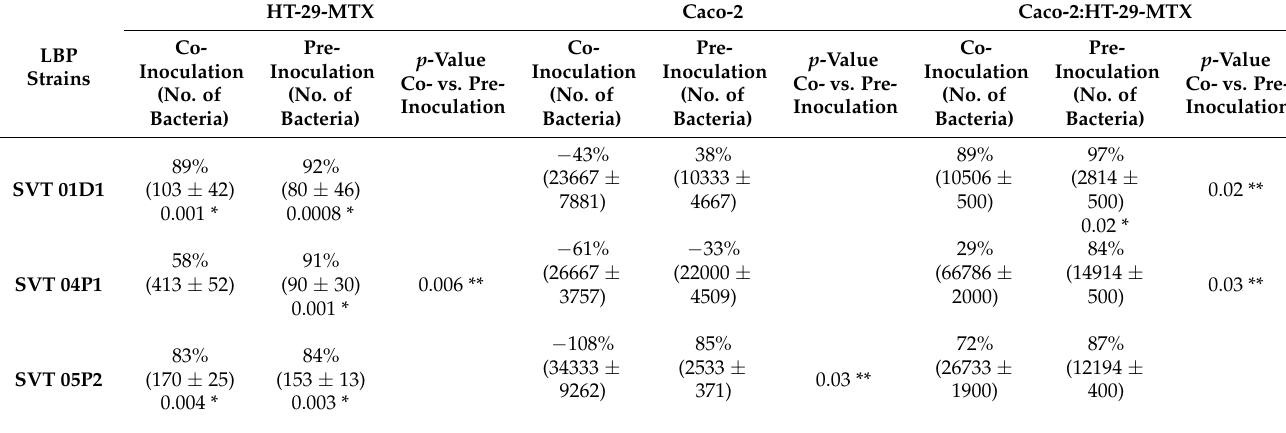
Table 2. The percentage of reduction in invasion of cell lines by AIEC and the number of AIEC cells invading cell lines (Mean ± SEM) in the presence of LBP strains (shown in bold letters) in both co-inoculation and pre-inoculation experiments. * Shows significance of reduction in the number of AIEC invading cell lines in the presence of the LBP strain versus the number of AIEC alone. ** Shows significance of reduction in the number of AIEC invading cell lines in pre-inoculation experiments versus co-inoculation. p -values that are only significant have been